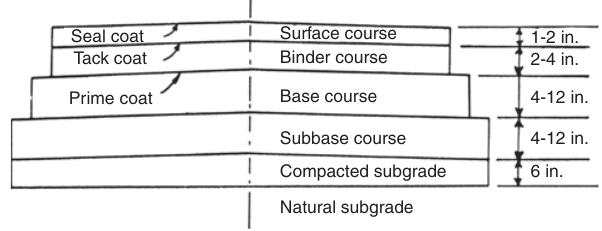
Figure 1 Typical cross-section of a conventional flexible pavement